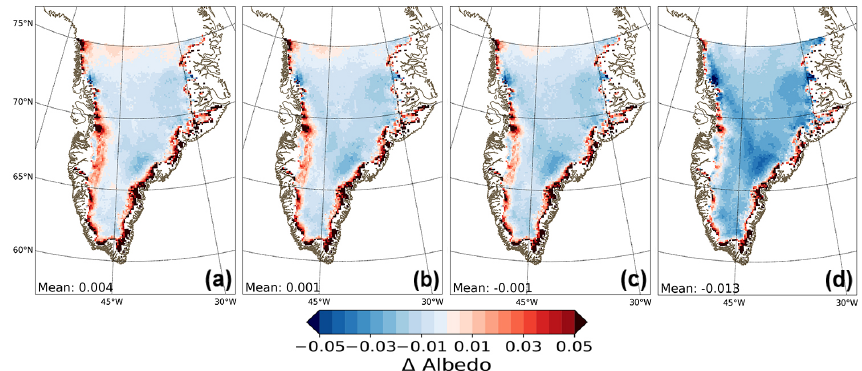
Figure 11. Bias-corrected average 16d running mean albedo difference for 15:00UTC between RACMO2.3p3 clear-sky albedo and MODIS MCD43A3 CSD albedo product, between 2011 and 2015, for (a) an impurity concentration of 0, (b) 5ngg − 1 , (c) 10ngg − 1 and (d) 50ngg − 1